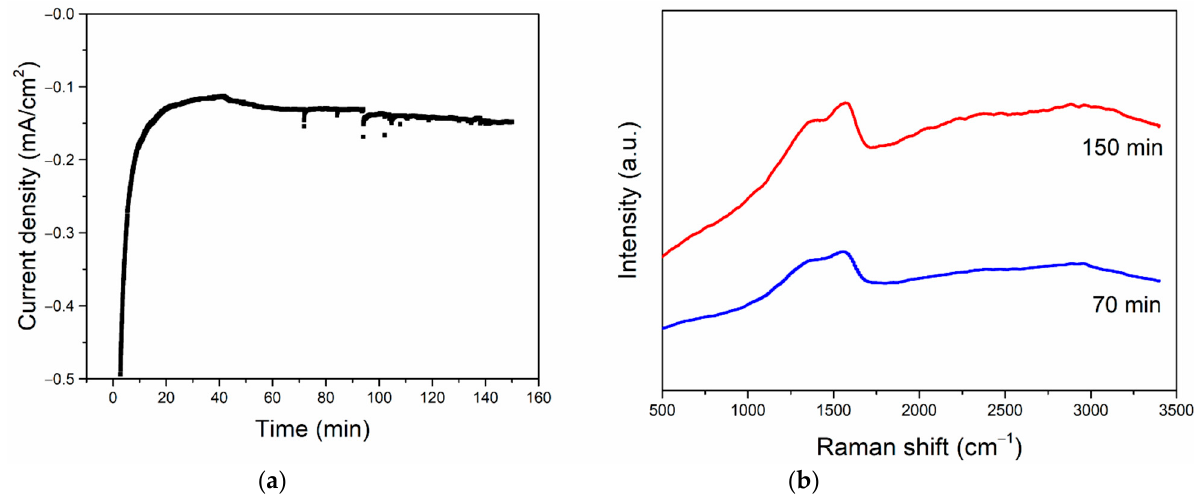
Figure 9 . Current density of 0.05Bi/Sn electrode in CO 2 RR at − 1.3 V vs. Ag/AgCl for 150 min ( a ) and Raman spectra of 0.05Bi/Sn electrode after CO 2 RR test at − 1.3 V vs. Ag/AgCl for 70 min (blue) and 150 min (red) ( b ).